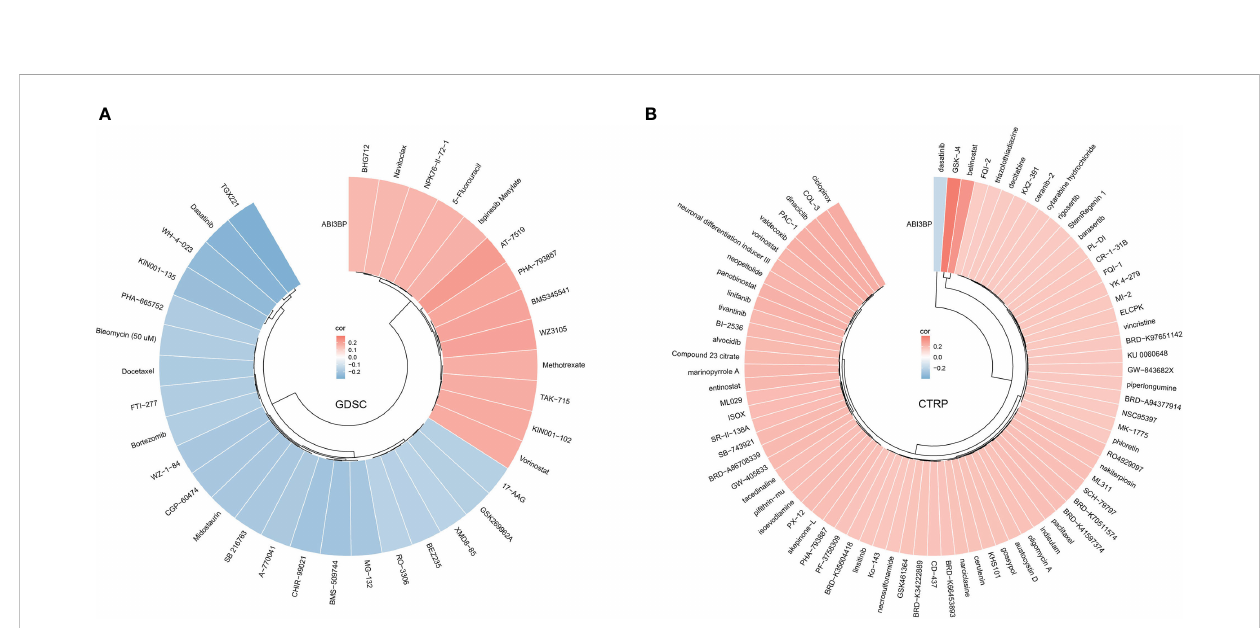
FIGURE 11 Relationship between ABI3BP expression and drug sensitivity. Correlation between ABI3BP expression and drug sensitivity to GDSC (A) and CTRP drugs (B) in